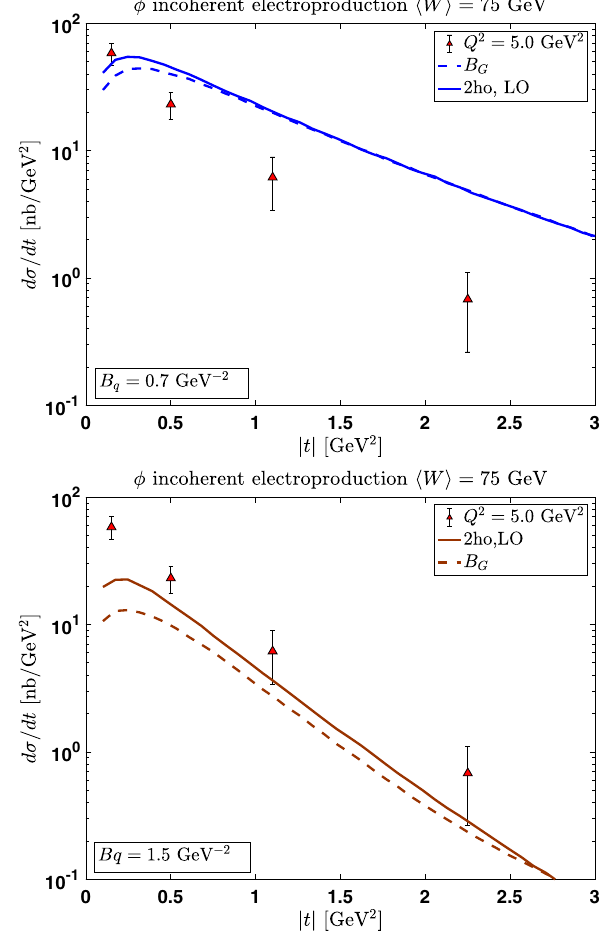
Fig. 15 Differential cross section for incoherent electroproduction of φ mesons as a function of the total momentum transfer (square) t . The data refer to the HERA H1 experiment [40] and are compared with present calculations within the QMBA (2 h.o.) (full lines) and the Gaus- sian ( B G ) approximation profiles (dashed lines). In the upper panel the “lumpy” density profile selected to describe fluctuations in the J /Ψ photo and electro production ( B q = 0 . 7 GeV − 2 ) is used and the pre- dictions overestimate the data at large | t | ; the lower panel results are obtained with a slightly “smoother” density profile ( B q = 1 . 5 GeV − 2 ) and are in good agreement with data. See